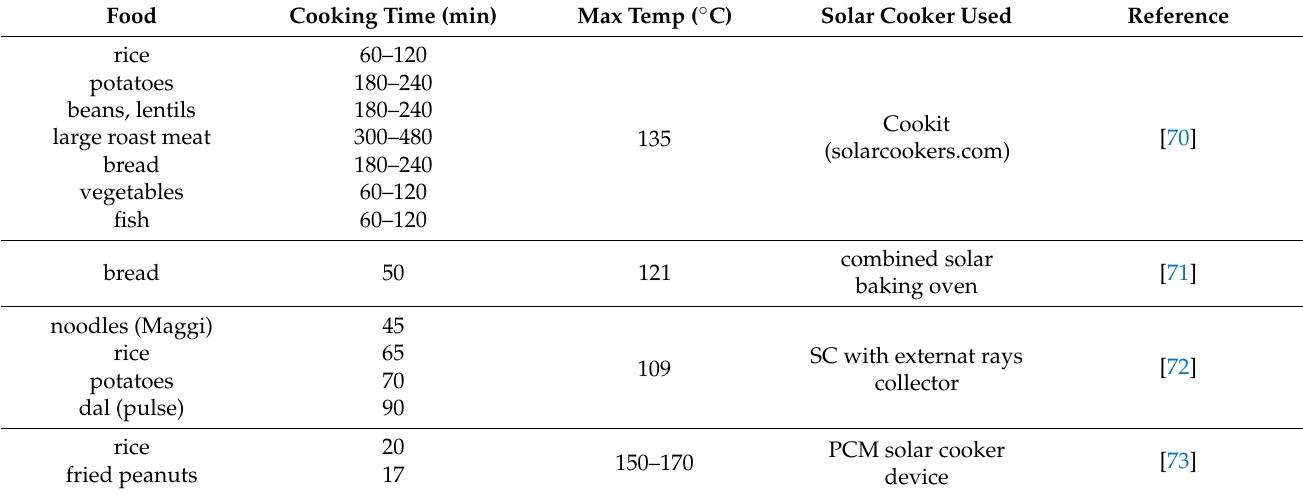
Table 1. Cooking time with different solar